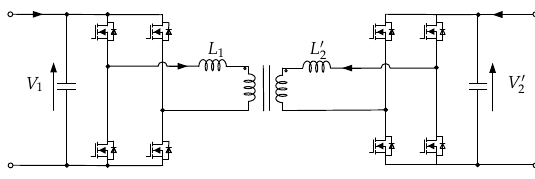
Figure 1. Dual active bridge (DAB) converter circuit.